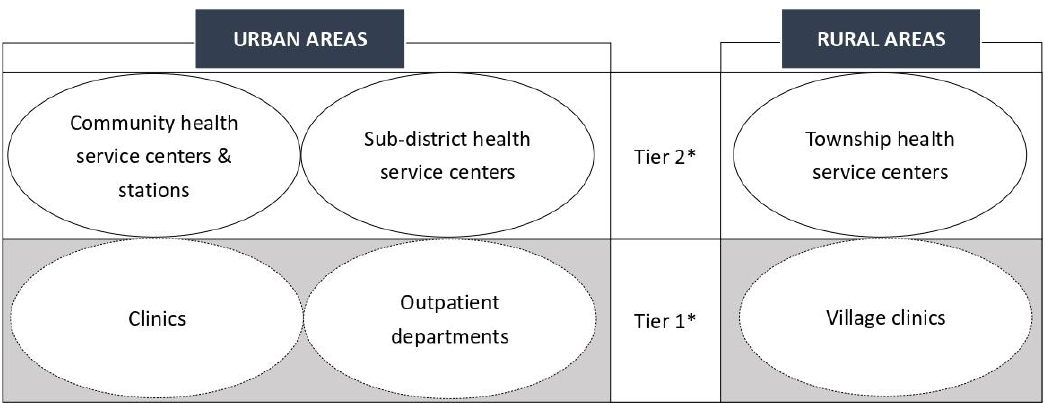
Figure 1. Primary health care providers in China. * China runs a three-tier healthcare system, and hospitals are at the top (i.e., tier 3).